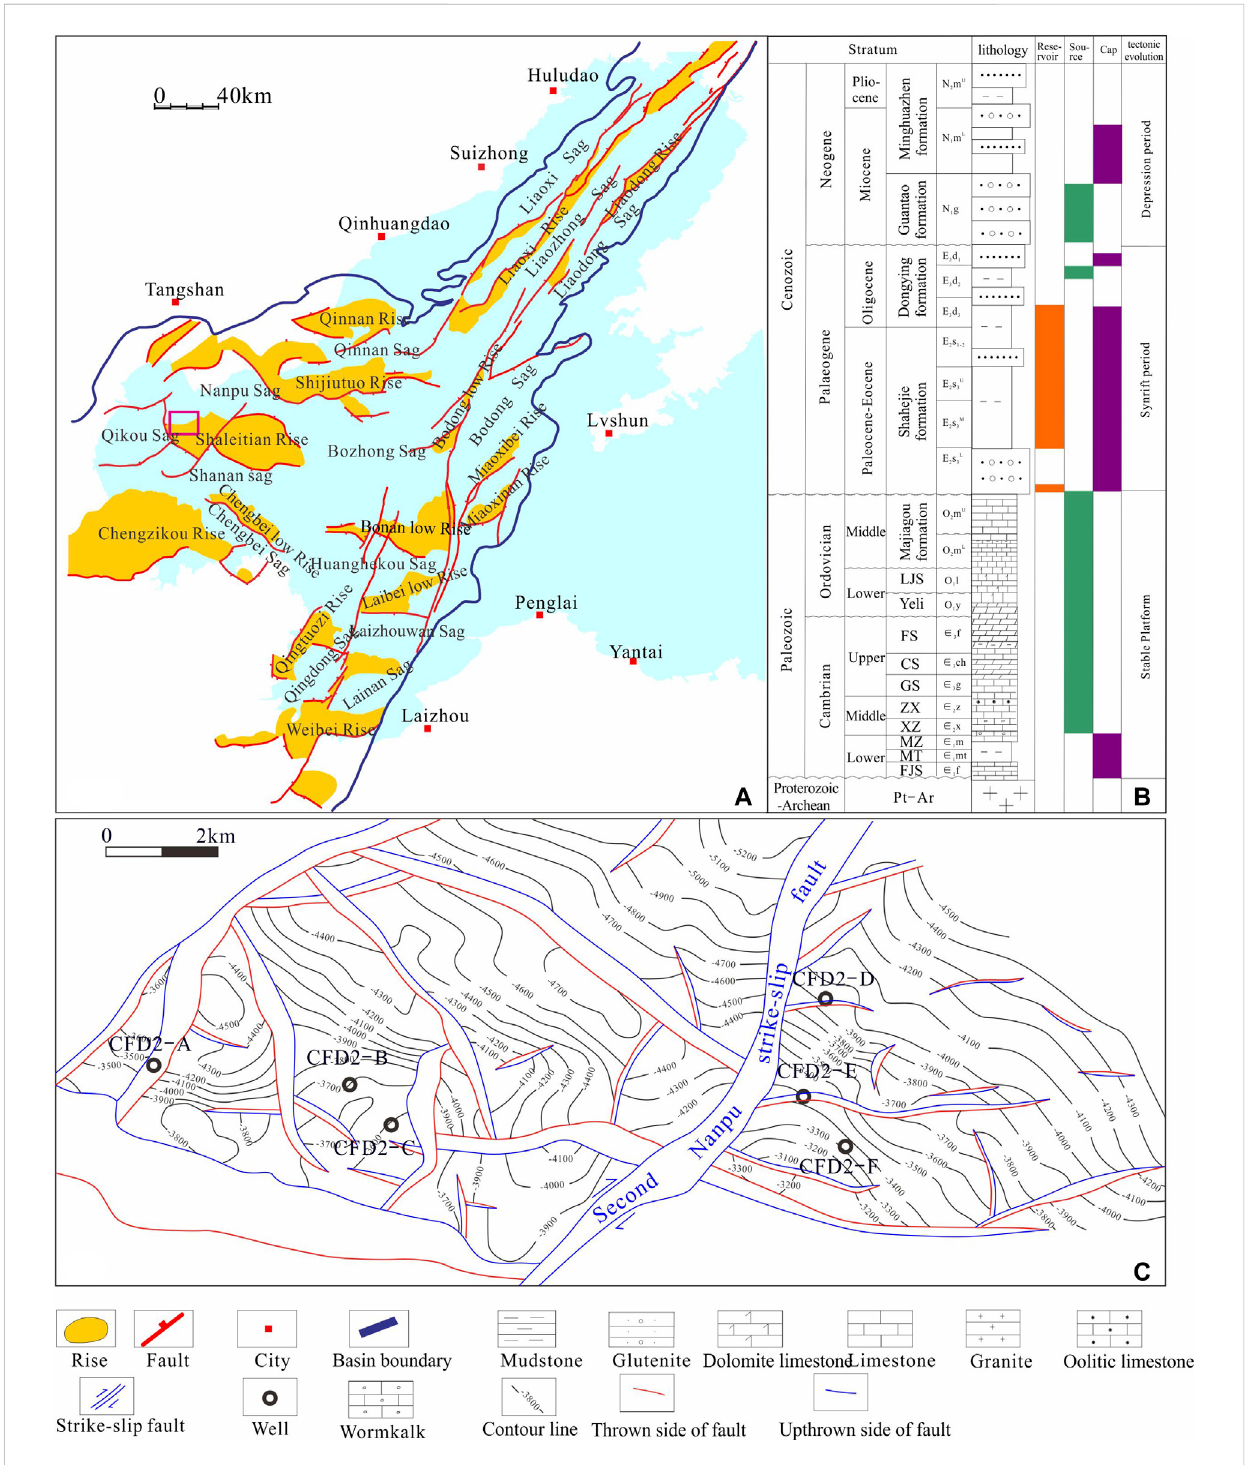
FIGURE 1 (A) :OutlineMapoftheoffshore BohaiBaybasin; (B) Comprehensivestratigraphicmap oftheoffshore BohaiBaybasin; (C) Structural outline mapof the CFD2 Oil fi